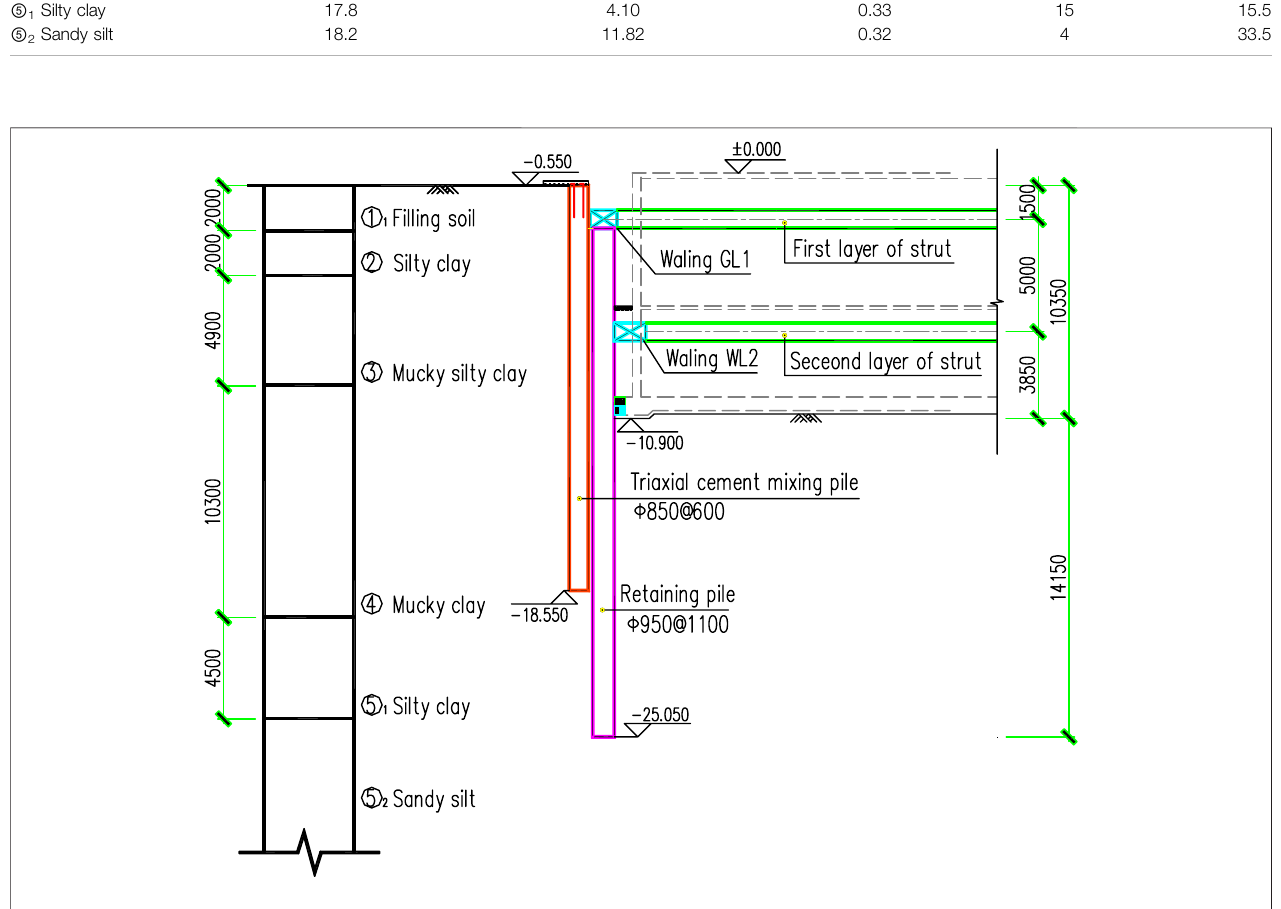
FIGURE 4 | Typical pro fi le of the retaining